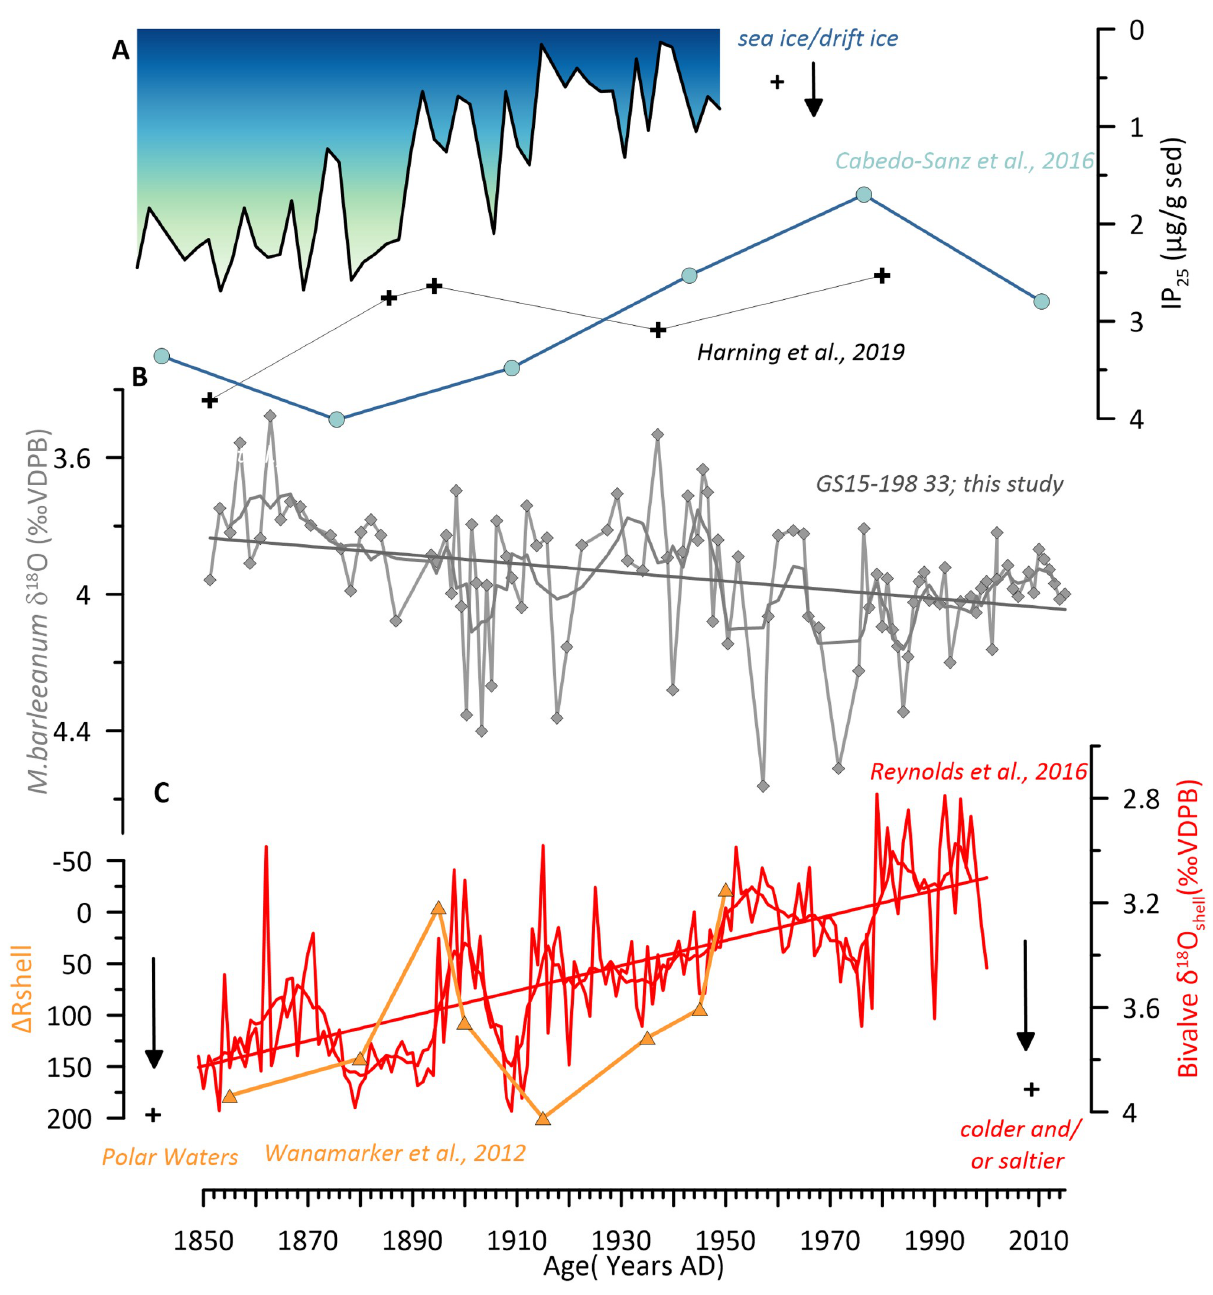
Fig 7. Comparison of selected marine climate proxies of core GS18-198-33 to other well-dated North Iceland shelf marine climate records. (A) IP 25 values reflecting sea ice advection/ drift ice to the NIS [94–96].(B) δ 18 O record of M . barleeanum . Trends are highlighted as linear regression lines. (C) Δ R in local schlerochronological records on the eastern NIS in orange and δ 18 O shell record measured in Arctic islandica